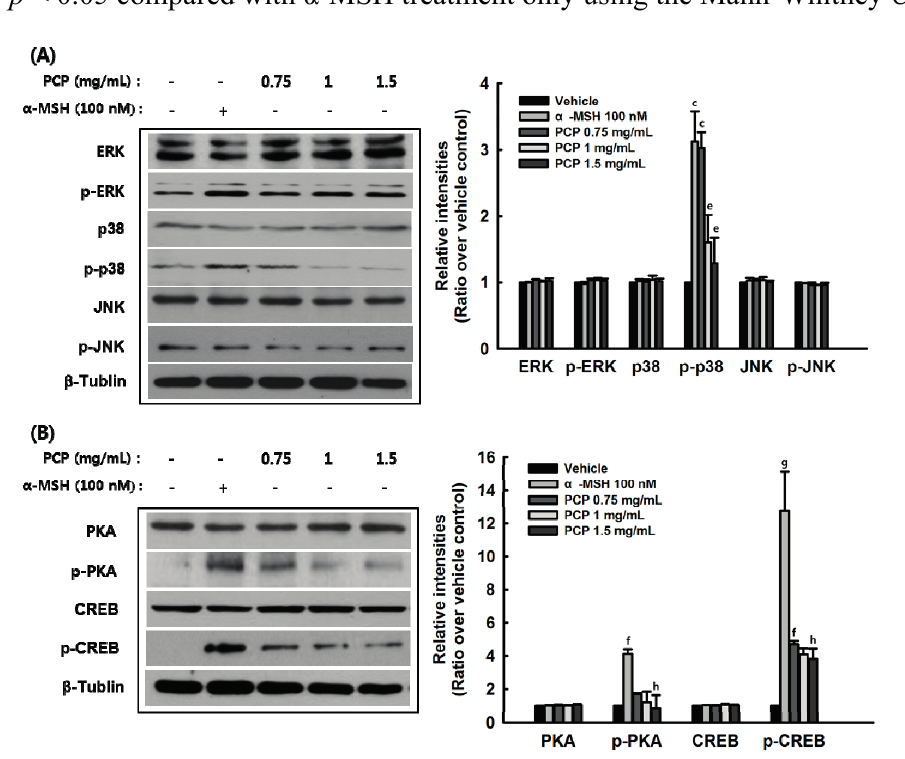
Figure 6. Effects of PCP on melanogenesis-related protein expression. B16F10 cells were exposed to various concentrations of PCP (0.75, 1 or 1.5 mg/mL) for 48 h following treatment with or without α -MSH (100 nM) for 24 h. Cellular proteins levels of TRP-1, TRP-2, tyrosinase, and MITF were examined by Western blot analysis. PCP, pomegranate concentrate powder; α -MSH, α -melanocyte-stimulating hormone; TRP-1, tyrosinase related protein 1; TRP-2, tyrosinase related protein 2; MITF, microphthalmia-associated transcription factor. a p < 0.05; b p < 0.01 or c p < 0.001 compared with the control (veh) using the LSD test; d p < 0.05; e p < 0.01 or f p < 0.001 compared with α -MSH treatment only using the LSD test; g p < 0.05 compared with the control (veh) using the Mann-Whitney U -test; h p < 0.05 compared with α -MSH treatment only using the Mann-Whitney U